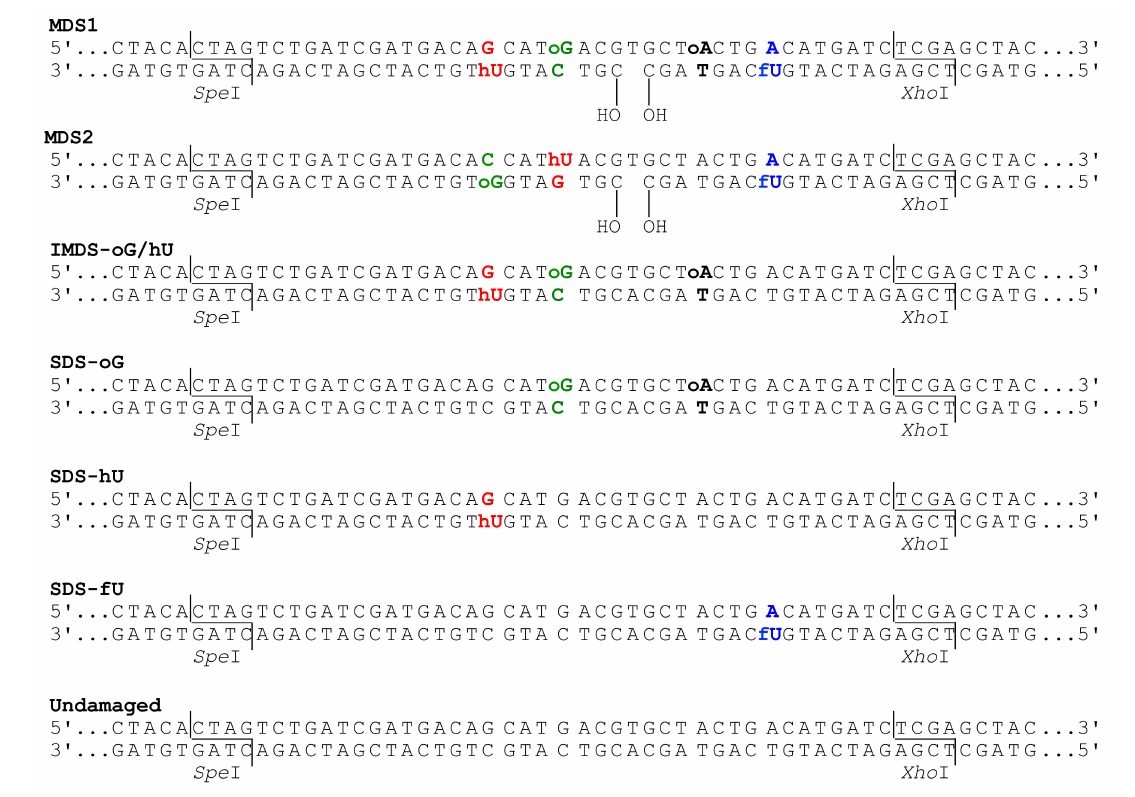
Figure 1. Duplexes carrying damaged sites used in this study. Oligonucleotides carried 8-oxoguanine (oG), 8-oxoadenine (oA), 5-hydroxyuracil (hU), and 5-formyluracil (fU). oG is located at 4 bp from hU in MDS1, MDS2, and IMDS-oG/hU. MDS1 and MDS2 carry a 1 nt gap terminated by 3 (cid:48) OH and 5 (cid:48) OH. All duplexes are 56 bp long and harbor Spe I and Xho I restriction sites at each